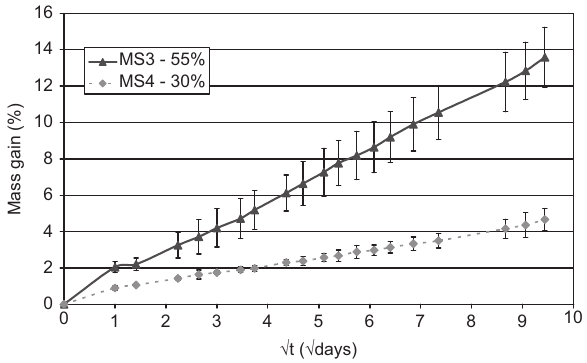
Figure 10 Acoustic emission activity of MS1 aged at 100 ° C [number of hits vs. load (kN/10)].